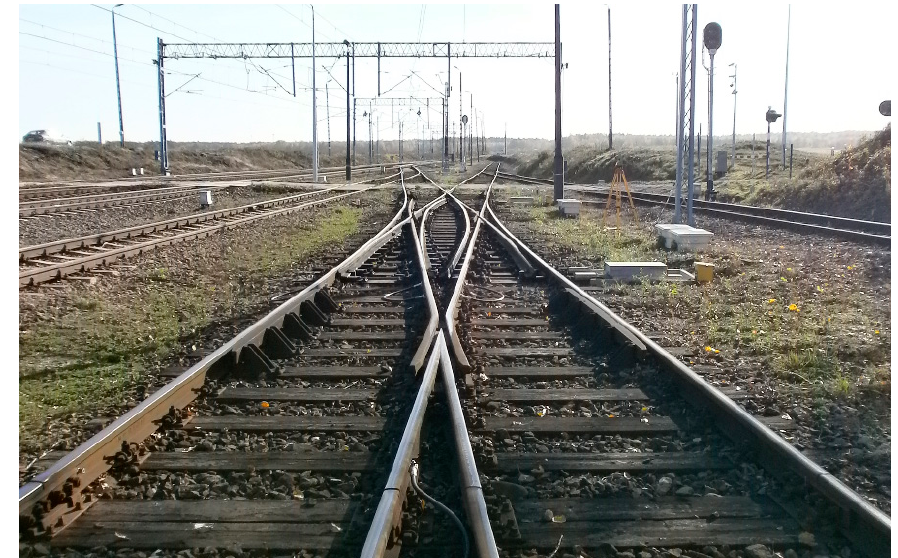
Figure 3. SMDOST-monitored double slip turnout with blades inside the quadrangle Rkpd iwew . The measurement Rkpd iwew was performed using MMS with a Leica GMP111 mini prism, prism constant + 17.5 mm (Figure 4), and an electronic total station TC407 Leica. The accuracy of the measured points m p(pom) at the Rkpd iwew No. 9 turnout using the polar method m p(pom) was 0.002 m, the line-of-sight error (H z -collimation) was 0.0000 g , and the V z -Index (Vertical index error) was 0.0000 g . The measuring station of the electronic total station was located in the intertrack space in the middle of the total length of the double slip turnout, outside the infrastructure gauge (structure gauge). the instrument lengths (line of sight / collimation axis) of all the measuring points. This study excluded